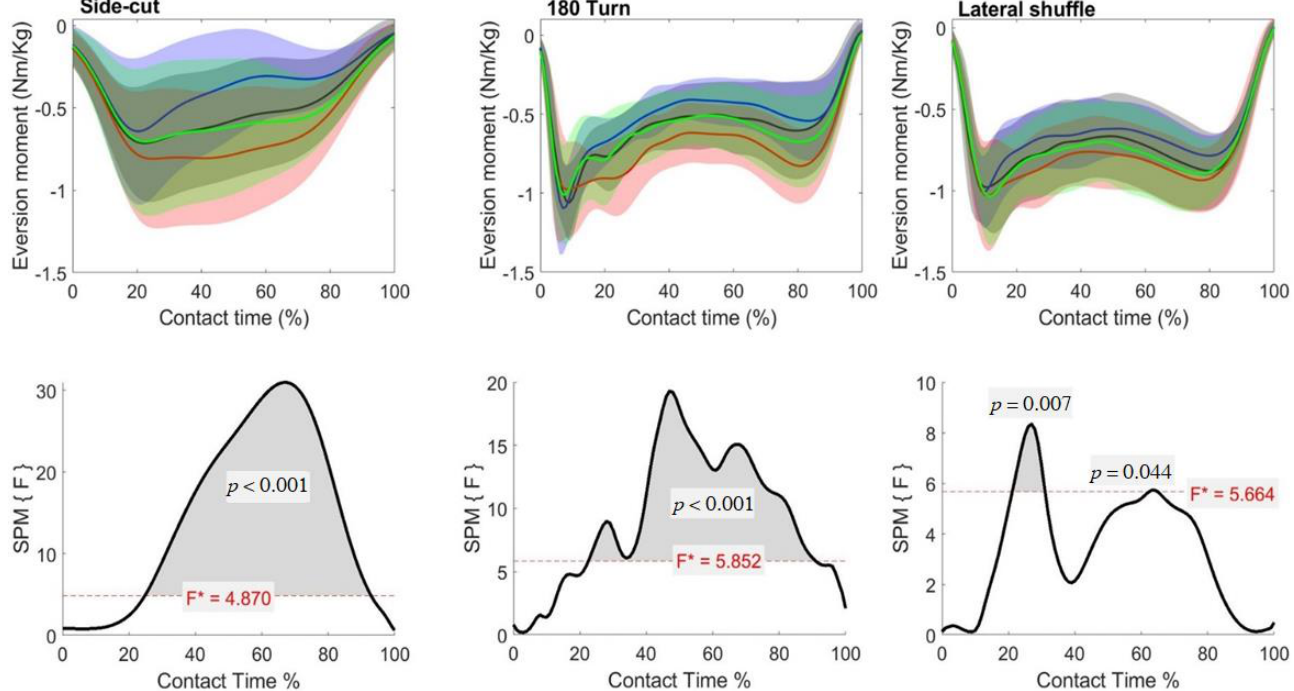
Figure 7. Mean (SD) frontal ankle moment across participants for each shoe condition (Black = Control, Blue = Forefoot, Red = Rearfoot; Green = Full) ( top ). The SPM(F) values across ground contact time ( bottom ). F* = critical value